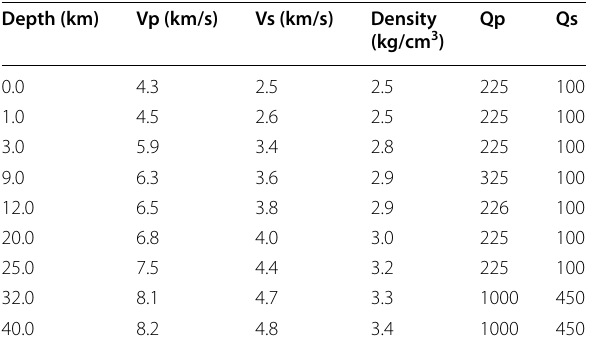
Table 2 Velocity model for the northern Red Sea after Hosny et al. (2009) utilized for calculation of the synthetic seismograms and spectral